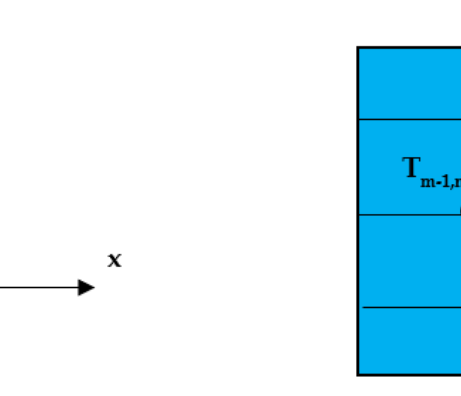
Figure 2. Schematic diagram of the volume element in the center of a node m, n of the PCM. PCM block in the sensible heat zone: